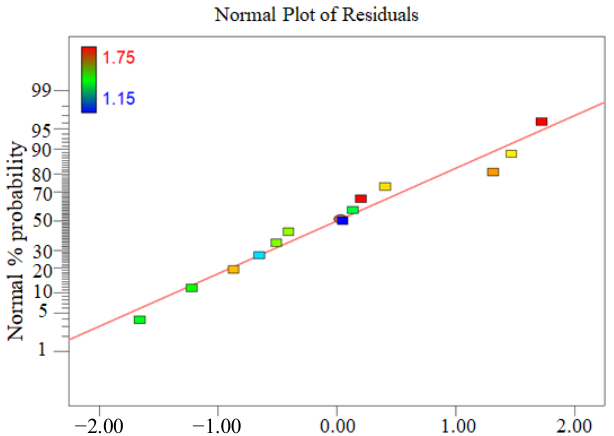
Figure 6. Normal probability distribution of the residual oil rate.